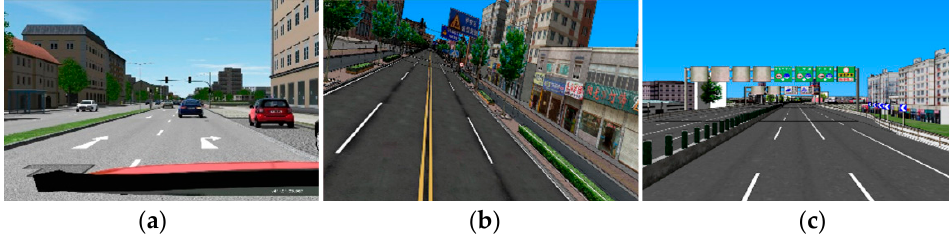
Figure 2. The three simulated environments. ( a ) urban road; ( b ) rural road; ( c ) motorway. This study employed a 3 (driving scenario) × 3 (eyes-off-road duration) within-sub- jects design. The three types of driving scenarios (urban road, rural road, and motorway) were crossed with the three durations of eyes-off-road condition (0, 1, and 2 s), resulting in nine combinations, henceforth called sub-trails. Thus, each participant conducted 9 sub- trails. The order of appearance of 9 sub-trails was basically the same across participants to avoid learning effect, and they were set for each participant before the experiment. Each sub-trial was about 5 min long, and there was a 200 m neutral phase connecting each sub- trial. The neutral phase was not included in the analysis.